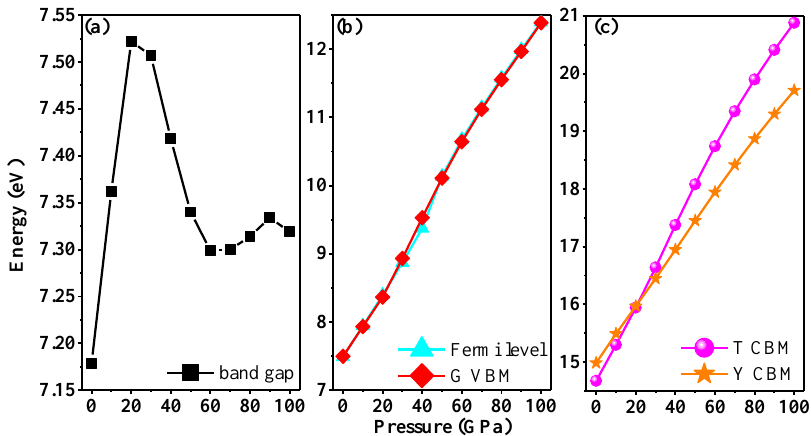
Figure 8. The band gap under pressure of Pnma -BN ( a ), the Fermi level and the energy of G high-symmetry points along valence band maximum (VBM) ( b ); the energy of T and Y high-symmetry points along conduction band minimum (CBM) ( c ).